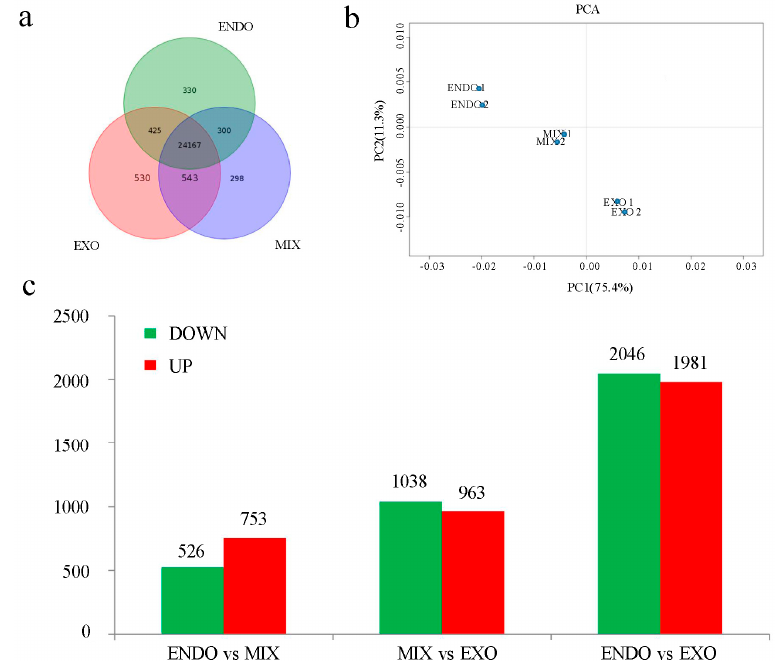
Figure 2. Bioinformatic analysis of RNA-seq data: ( a ) Venn diagram showing the developmental distribution of the genes detected; ( b ) principle component analysis (PCA) of gene expression in ENDO, MIX and EXO groups and ( c ) the number of differential expression genes between ENDO and MIX, ENDO and EXO, and MIX and EXO group.